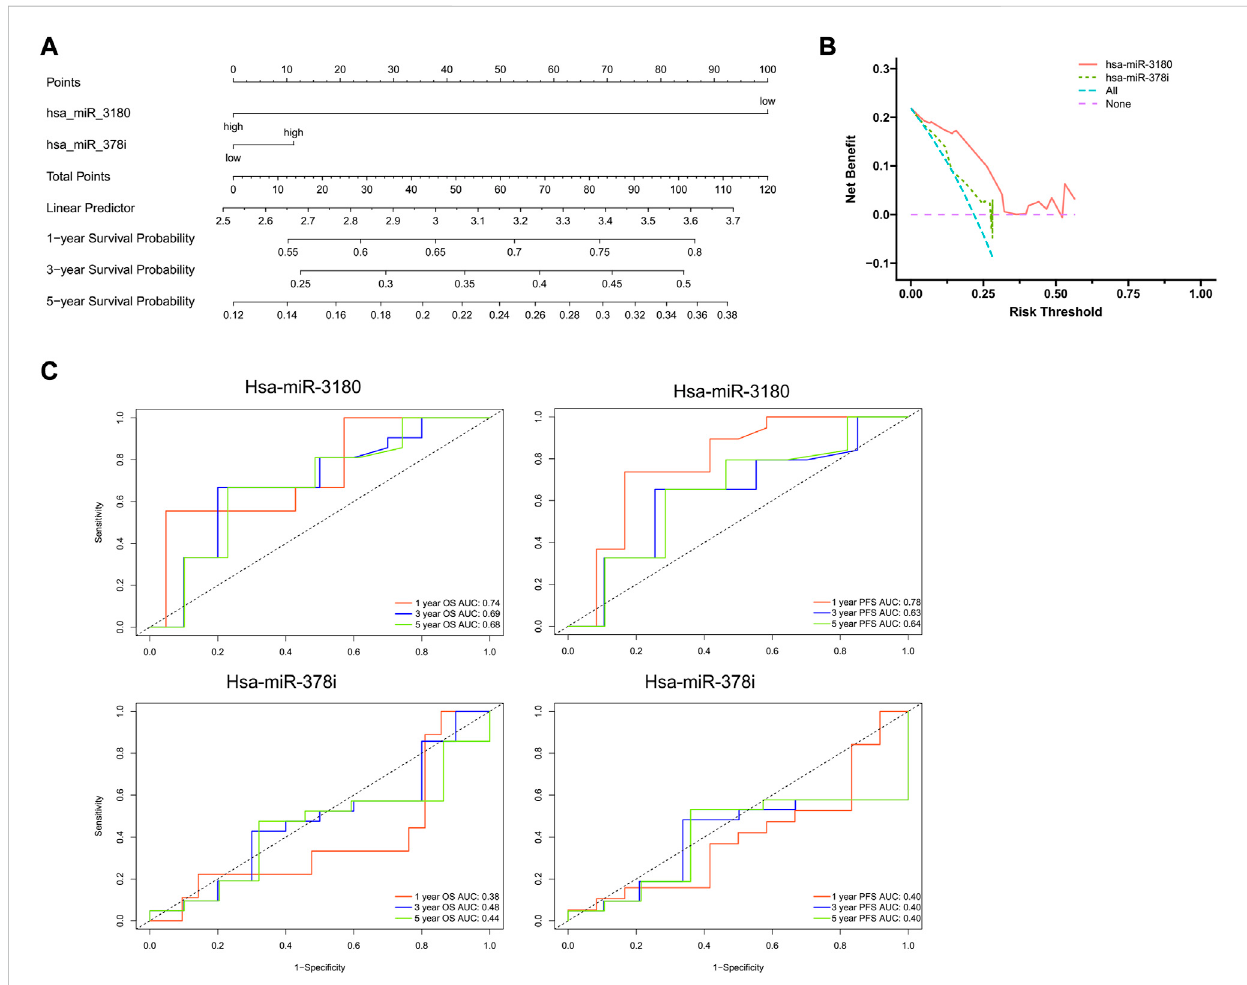
FIGURE 4 Nomogramconstructionandevaluation. (A) Nomogramsbasedonhsa-miRNA-3180andhsa-miRNA-378i wereused topredicttheprobabilitiesof 3-and5-yearOS. (B) Decisioncurveanalysisforthenomogram,hsa-miR-3180,andhsa-miR-378i.Thex-axisshowsthethresholdprobability,andthey- axis measures the net bene fi t. The red line represents the model with hsa-miR-3180. The olive line represents the model with age hsa-miR-378i. (C) Time-dependent ROC curve analyses of the sensitivity and speci fi city of hsa-miRNA-3180 and hsa-miRNA-378i for 1-, 3-, and 5-year survival. OS: overall survival; ROC curve: receiver operating characteristic